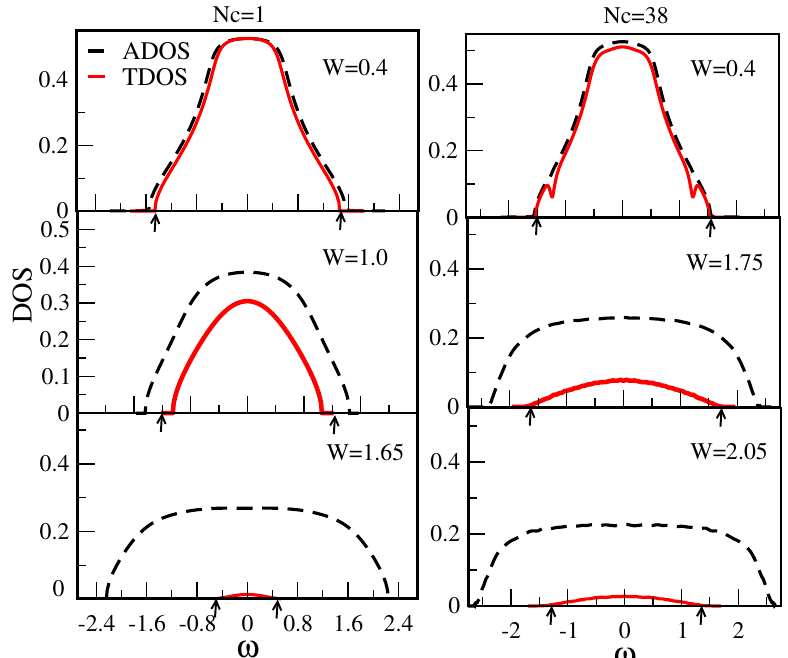
Figure 30. (Left) TMT ( N c = 1); (Right) TMDCA ( N c = 38). The ADOS (dash line) and the TDOS (solid lines) of the 3D Anderson model for different disorder strengths W in units where 4 t = 1. At low disoder, the ADOS and TDOS coincide. This also indicates that the TMDCA and the DCA solutions are very similar. As disoder strength W increases the TDOS becomes suppressed and vanishes above the transition. In the local TMT ( N c = 1) scheme, the mobility edge (indicated by arrows) moves towards the band center ω = 0 monotonically, while in the TMDCA the mobility edge first moves to higher energy, and roughly around W > 1.75 it starts moving towards the band center, indicating that TMDCA can successfully capture the re-entrance behavior missing in the TMT scheme. Reprint from